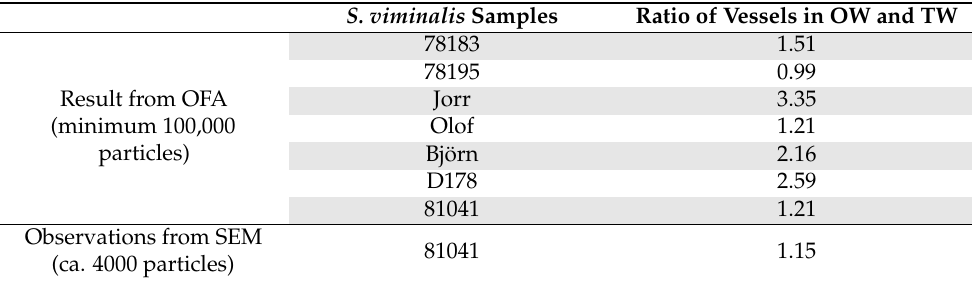
Table 6. Ratio of vessels in opposite and tension wood from seven S. viminalis